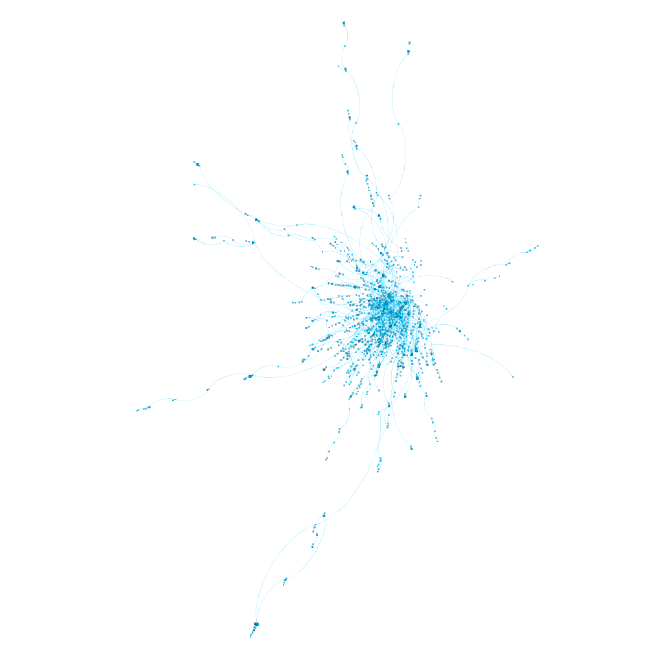
Figure 7. SC3 is the third largest sub-community is centred on vegan diet and